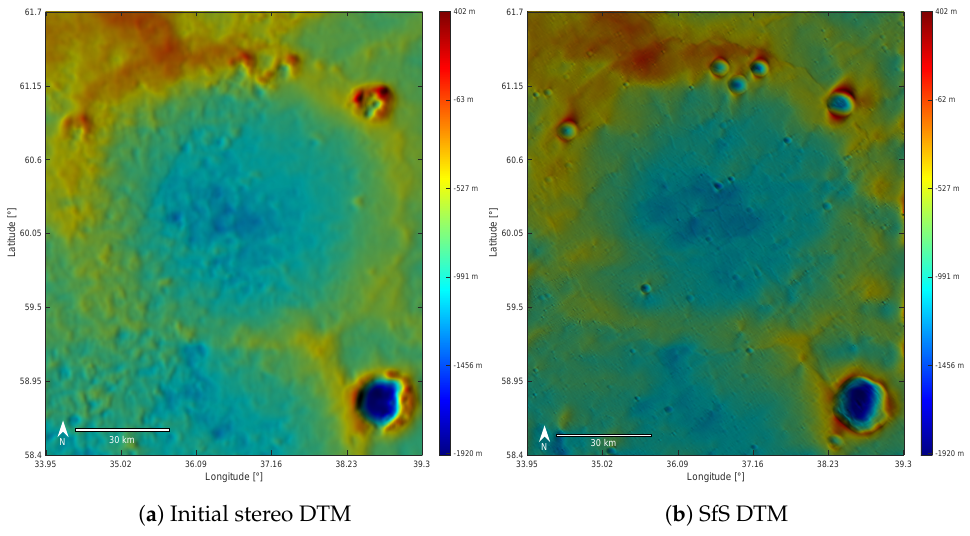
Figure 10. ( a ) Mosaic of WAC images of the ghost crater at a resolution of 155m/pixel. ( b ) Color-coded representation of the SfS DTM.